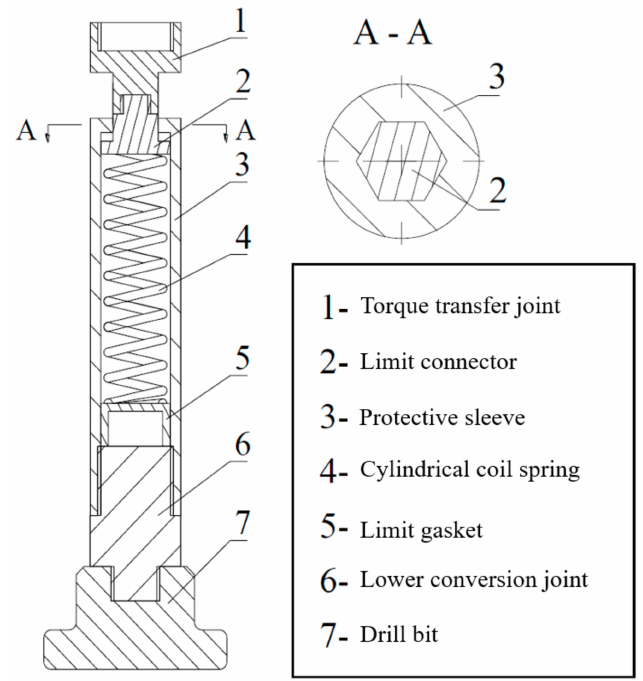
Figure 4. The diagram of spring